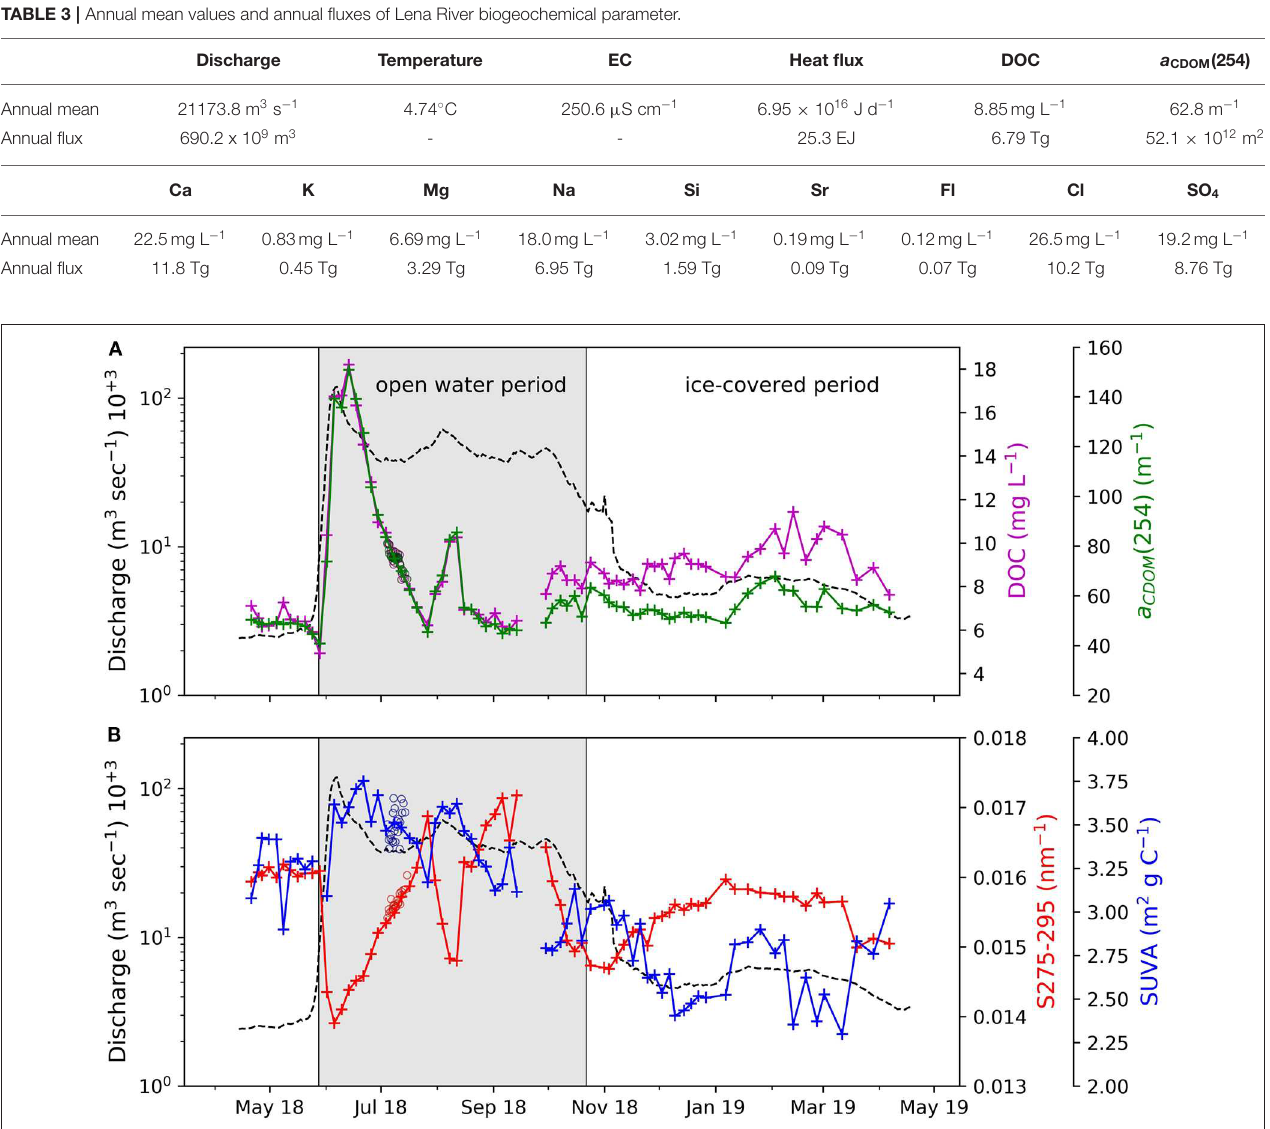
FIGURE 5 | Seasonal variation of DOC and a CDOM (254) (A) and S275-295 and SUVA (B) . Black dashed line shows the discharge. Circles in respective colors show high frequency measurements from July 2018.